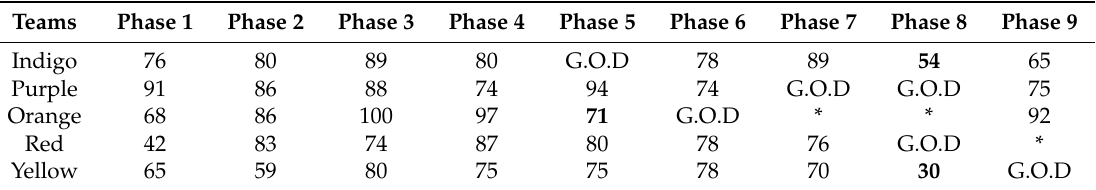
Table 4. Quantitative interaction